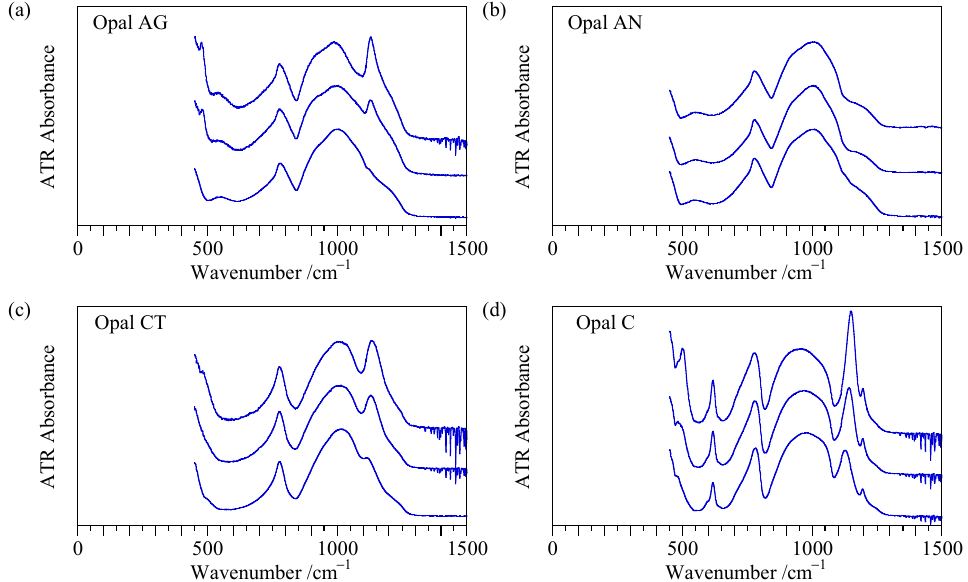
Figure A1. ATR of 3 different positions of resin embedded and polished slabs of ( a ) G7532 (boulder opal (AG) from Queensland) ( b ) MS-1 (opal-AN from Mount Squaretop, Queensland, Australia ( c ) G9942 (opal-CT from Angaston, South Australia, Australia, and ( d ) T1664 (opal-C from Guanajuanto, Mexico). Samples were recorded on the Nicolet instrument with Smart Orbit ATR accessory having a cracked diamond crystal.